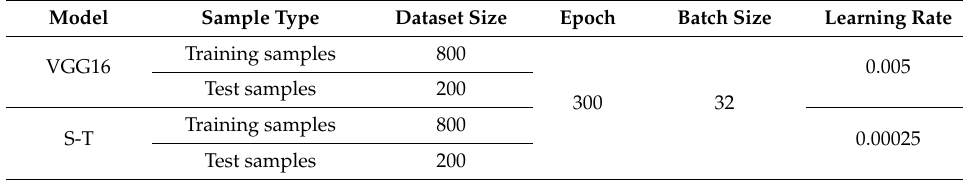
Table 2. Training parameters of each model.